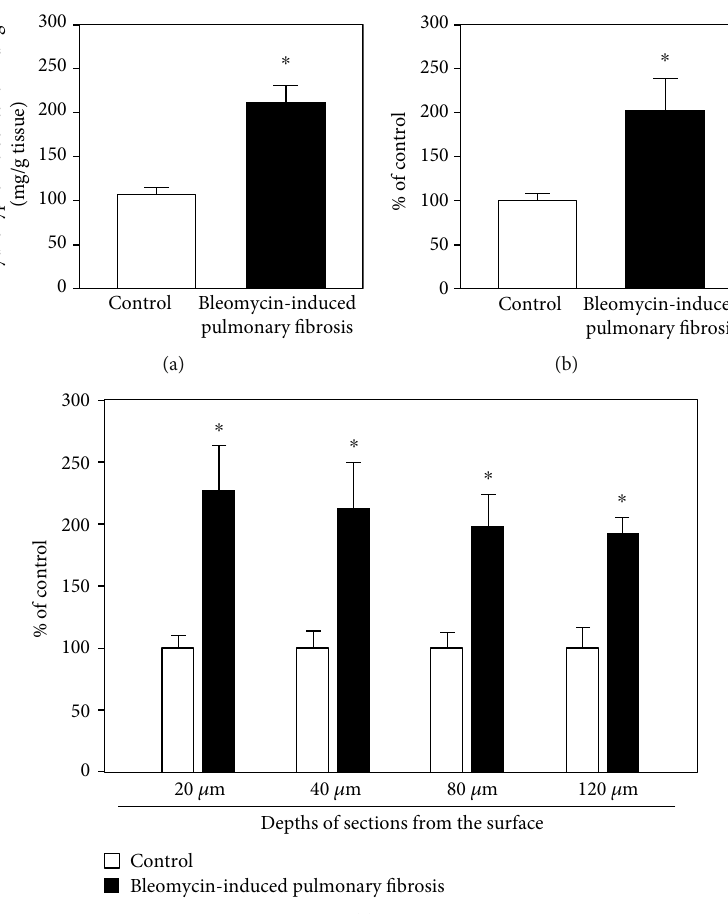
Figure 7: Quantitative analysis of fl uorescence-labeled fi brotic foci in the lungs using Col-F after Clear T2 tissue-clearing treatment. (a) Hydroxyproline content in fi brotic mouse lungs. (b) Blue coloration indicating extracellular matrix localization on the lung tissue section. (c) Fluorescent intensities derived from single-plane images of Col-F at the indicated depth ( μ m) from the lung surface. Each point represents the mean ± SD ( n = 3 ). ∗ p < 0 : 05